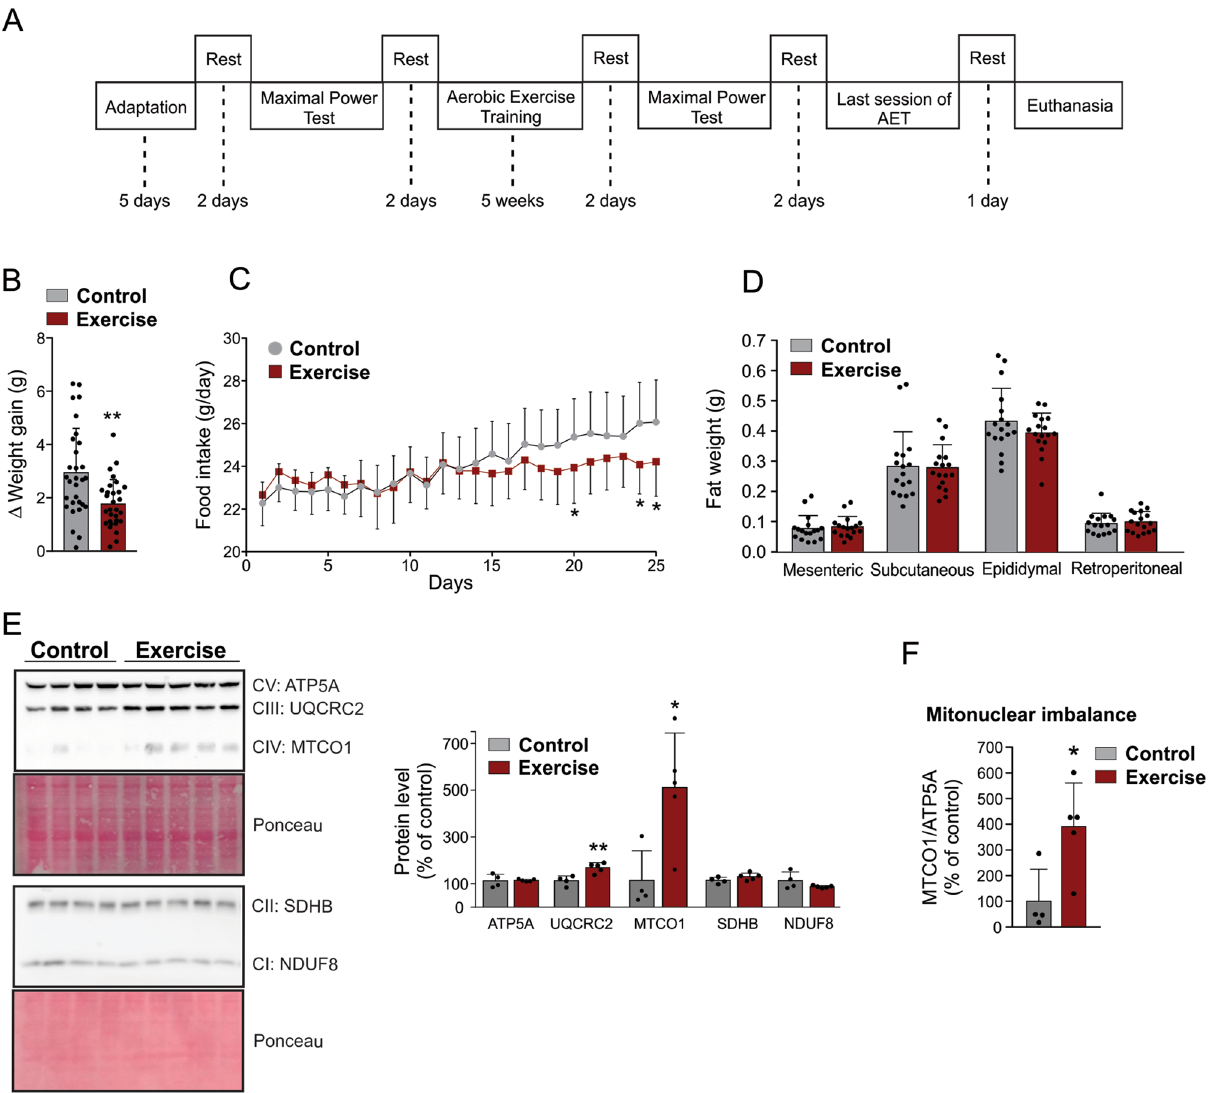
Figure 3. Effect of exercise on OXPHOS components and mitonuclear imbalance in hypothalamic tissue. ( A ) Experimental design. ( B ) Body weight gain (n = 30 per group). ( C ) Food intake (n = 15 per group). ( D ) Fat mass depots (n = 17 per group). ( E ) Western blot showing the oxidative phosphorylation complex components (control, n = 4, and exercise, n = 5). ( F ) mt-CO1/ATP5a ratio, for characterization of mitonuclear imbalance (control, n = 4, and exercise, n = 5). AET: aerobic physical training. “Student’s t-test (two-tailed); * p < 0.05 versus control group. ** p < 0.01 versus control group. Full-length blots are presented in Supplementary Figure S4. Figures ( B – F ) were created in CorelDRAW 2019 software (version 21.0.0.593—https ://www.corel